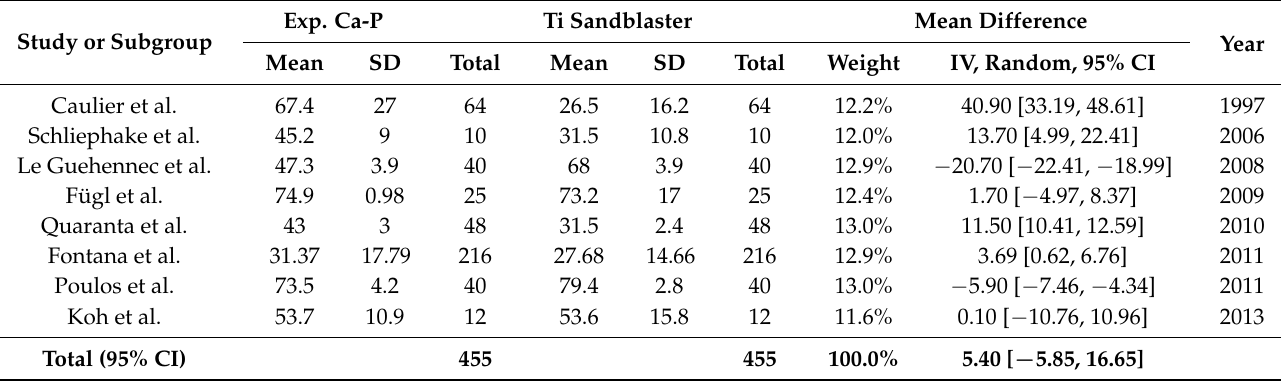
Table 5. Meta-analysis of BIC according to random-effects model.